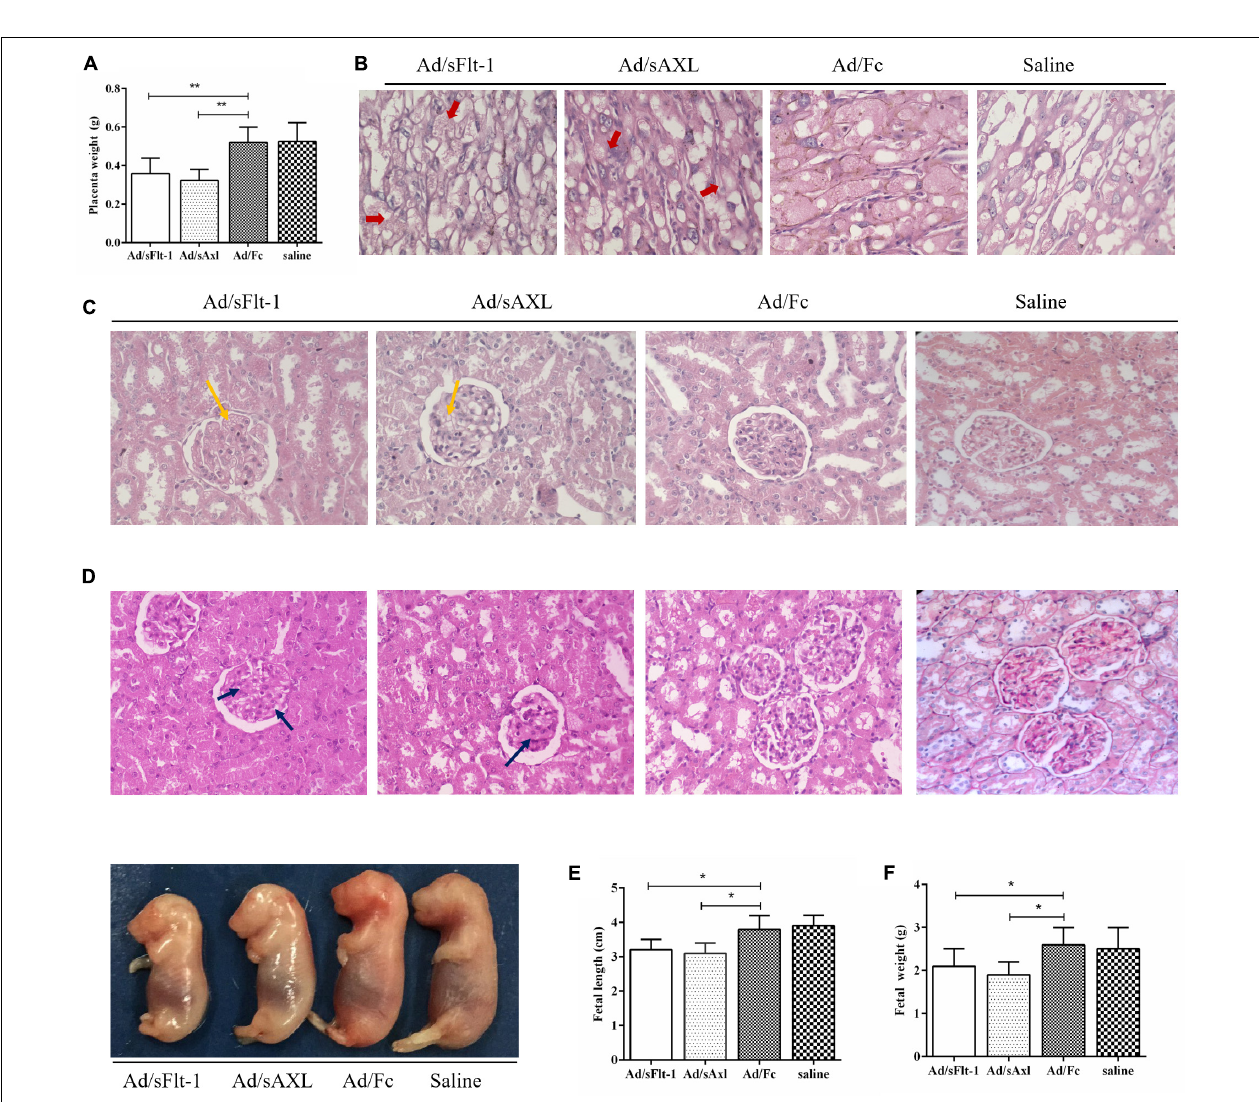
FIGURE 6 | Effects of sAxl on the maternal placenta, kidney, and fetal development in rats. (A) Placenta weight. (B) Placenta morphology was detected by HE staining (400x, red arrow). (C,D) Kidney morphology was detected by H&E and PAS staining (400x, yellow and blue arrow). (E,F) The fetal weight and length of rats. The results are presented as mean ± SD.* p < 0.05, ** p < 0.01 vs. respective controls. n = 6 per group.